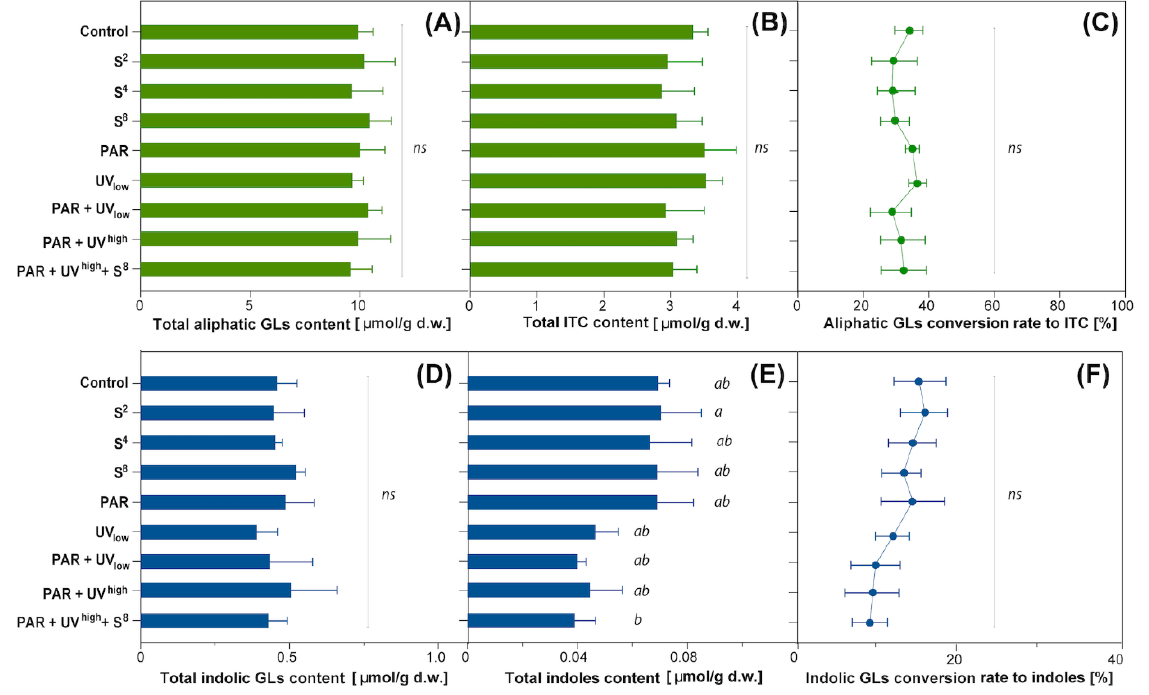
Figure 5. The contents of total aliphatic ( A ) and total indolic ( D ) GLS and the contents of corre- sponding total ITC ( B ) and total indoles ( E ) formed after autolysis of GLS were calculated as means +/− SD based on determinations for samples of treated and untreated white cabbage leaves derived from 3 independent experiments analysed in duplicates. The percentiles of conversion rates of GLS to respective breakdown products ( C , F ) were calculated for each pair separately, then means +/− SD were obtained for a given treatment. For treatment codes, see Table 1. The results marked as ns refer to no significant differences between treatments within the column/compound according to the analysis of variance at P ≤ 0.05. Numbers followed by the same letters within one graph are not significantly different according to Tukey ’s multiple comparison test at P ≤ 0.05.